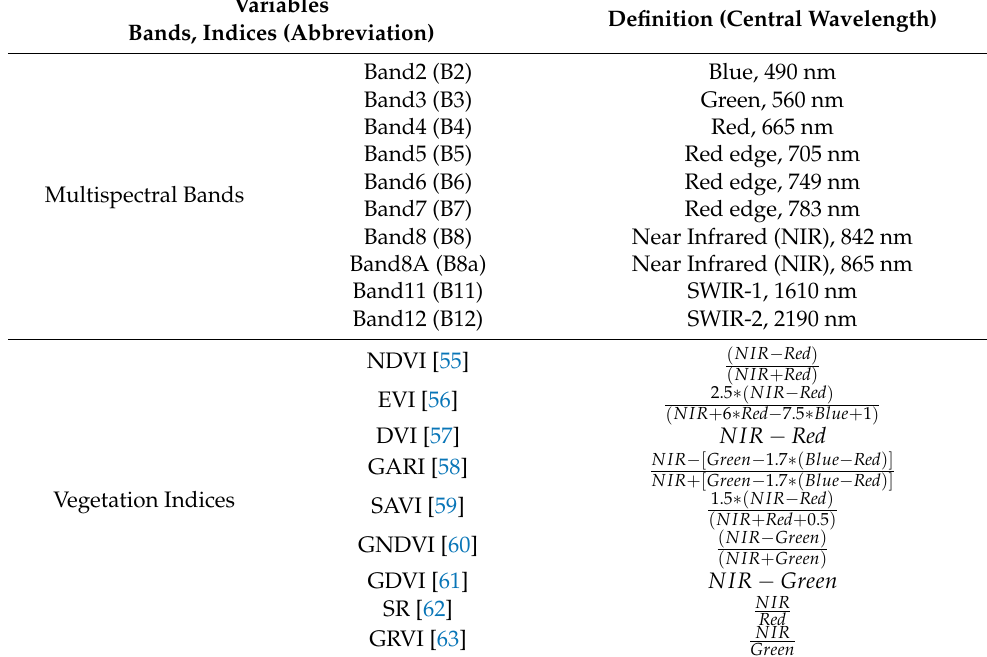
Table 4. List of variables from the Sentinel2-MSI data. Vegetation indices: DVI, difference vegetation index; EVI, enhanced vegetation index; GARI, green atmospherically resistant vegetation index; GDVI, generalized difference vegetation index; GNDVI, green normalized-difference vegetation index; GRVI, green/red vegetation index; NDVI, normalized-difference vegetation index; SAVI, soil-adjusted vegetation index; SR, simple ratio vegetation